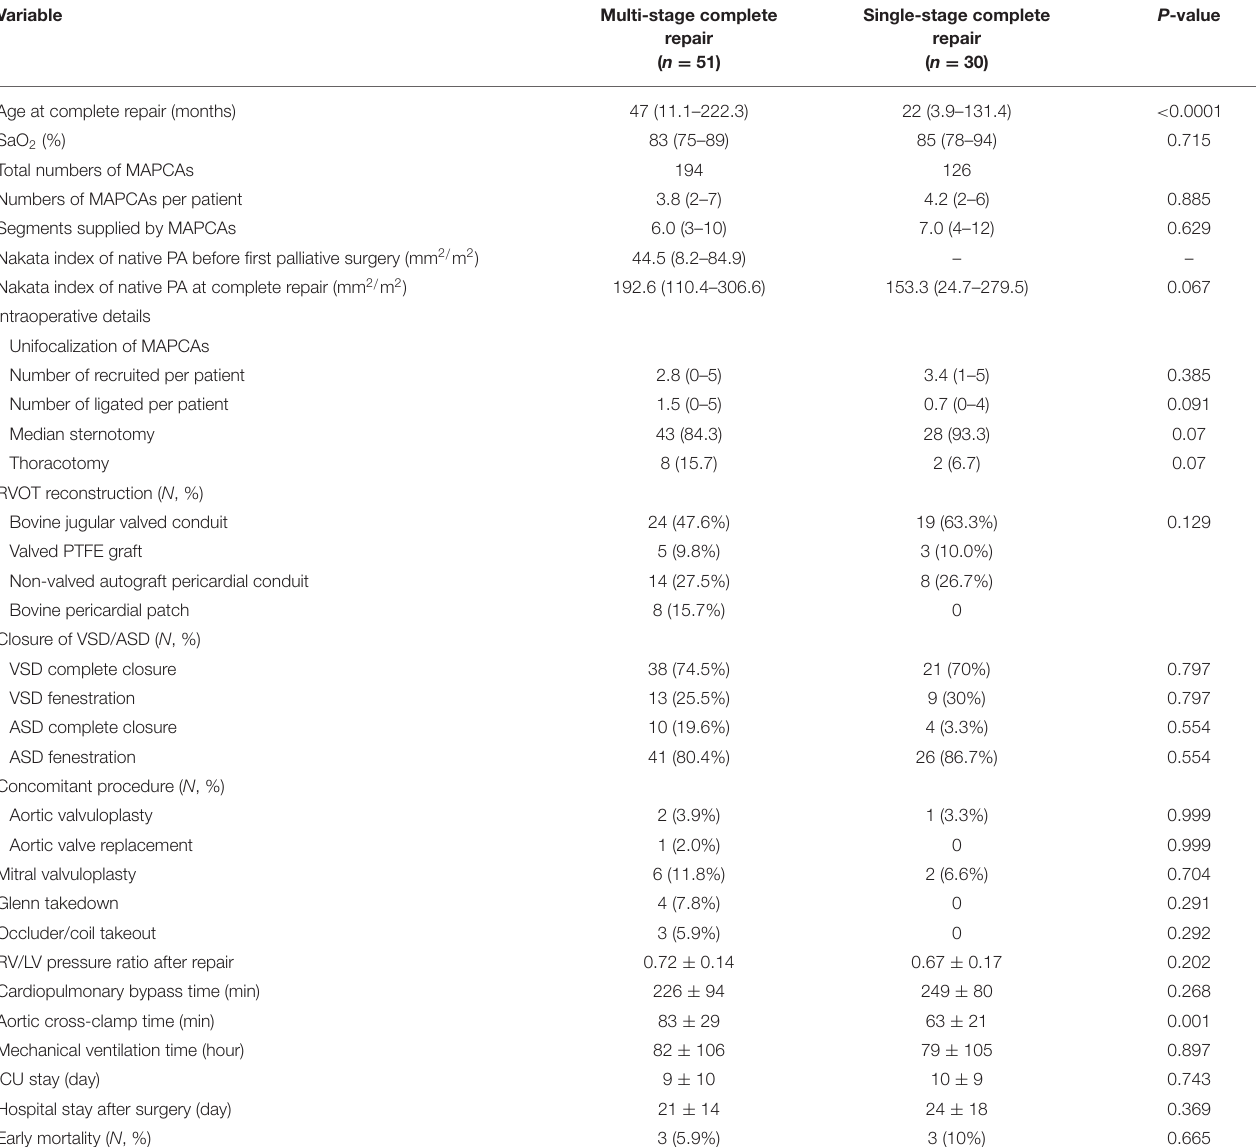
TABLE 2 | Characteristics and operative details of patients undergoing complete repair.